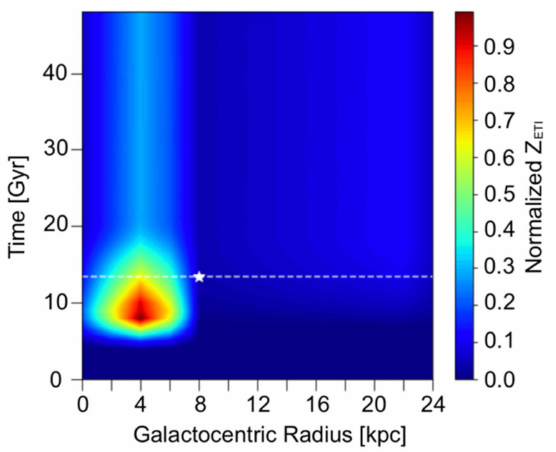
Figure 2. Normalized spatial–temporal profile for Z ETI over 50 Gyrs, when λ A = 10 − 6 Gyr − 1 , P ann = 0 and T evo = 5